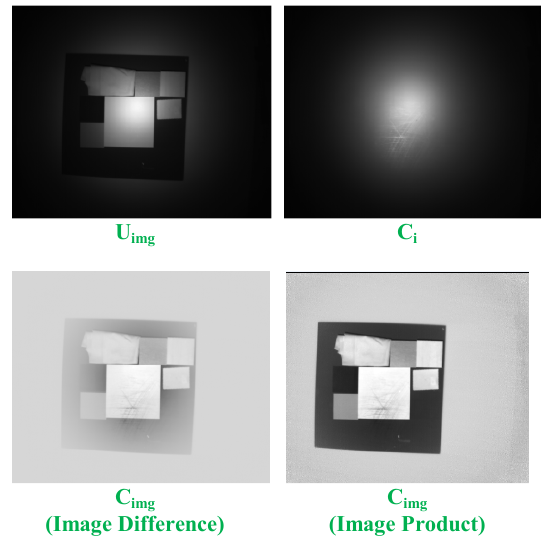
Figure 4. The 90% white panel image corrected for illumination distribution using two different algorithms As is seen in Figure 4, the Image Difference algorithm does not sufficiently correct the image, introducing in some instances